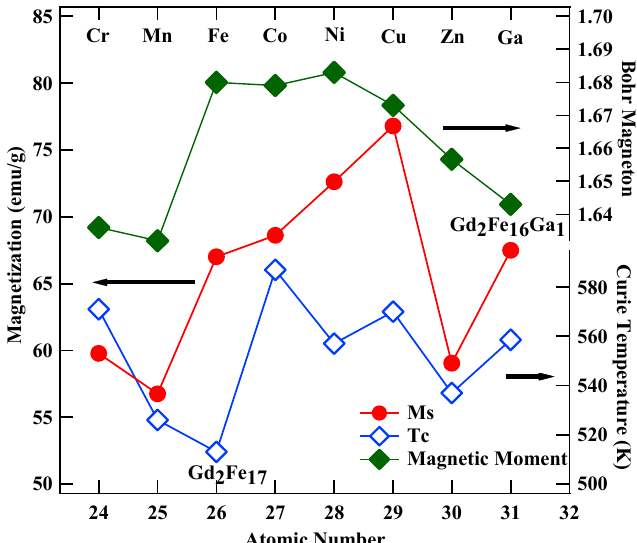
Figure 5. Saturation magnetization, Ms , Curie temperature, Tc , and Bohr magneton number as a function of TM atomic number in Gd 2 Fe 17 and Gd 2 Fe 16 Ga 0.5 TM 0.5 (TM = Cr, Mn, Co, Ni, Cu, Zn, and Ga).